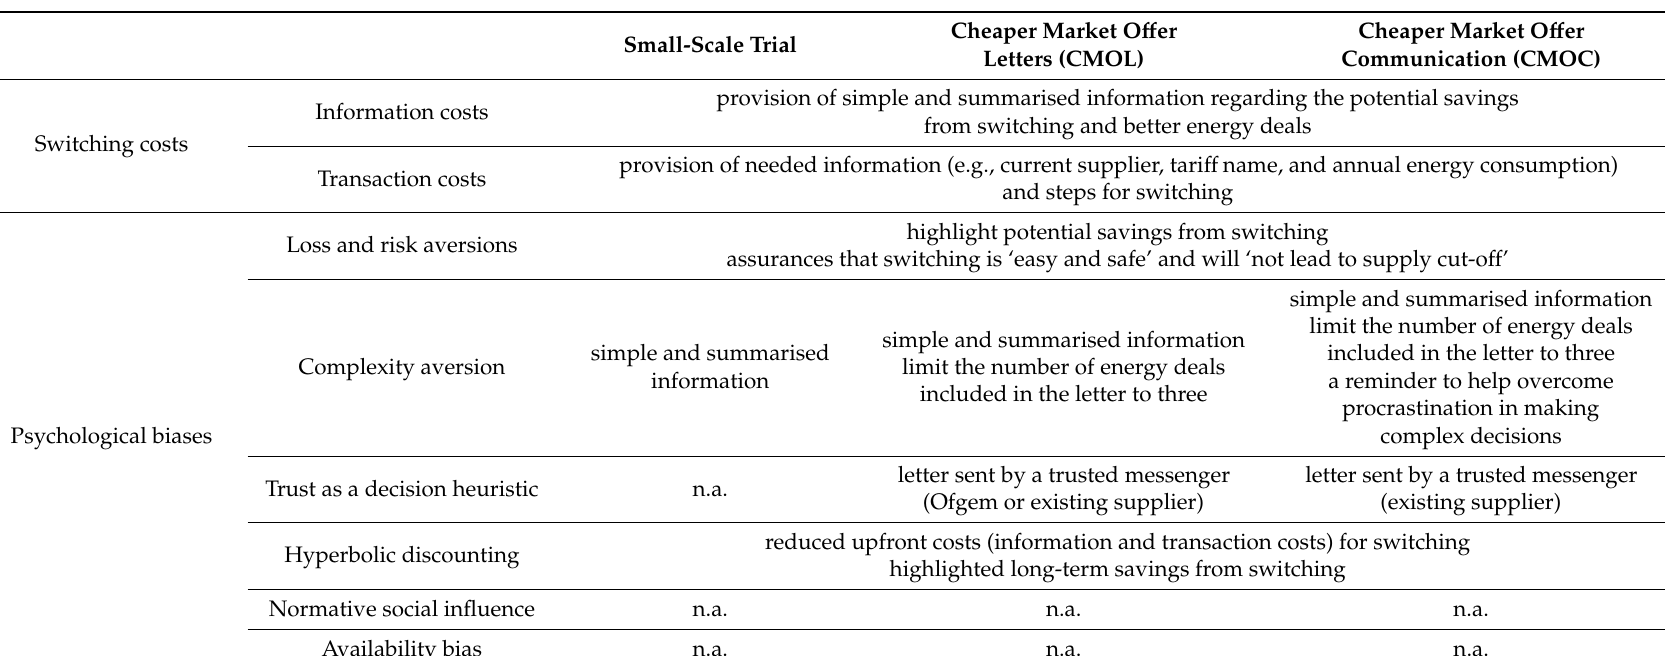
Table 2. The Better O ff er trials: Key